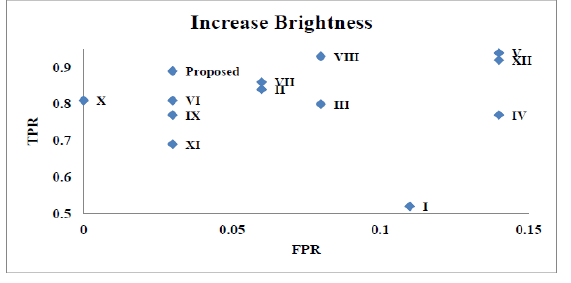
Figure 6. TPR vs. FPR: Gaussian Noise.